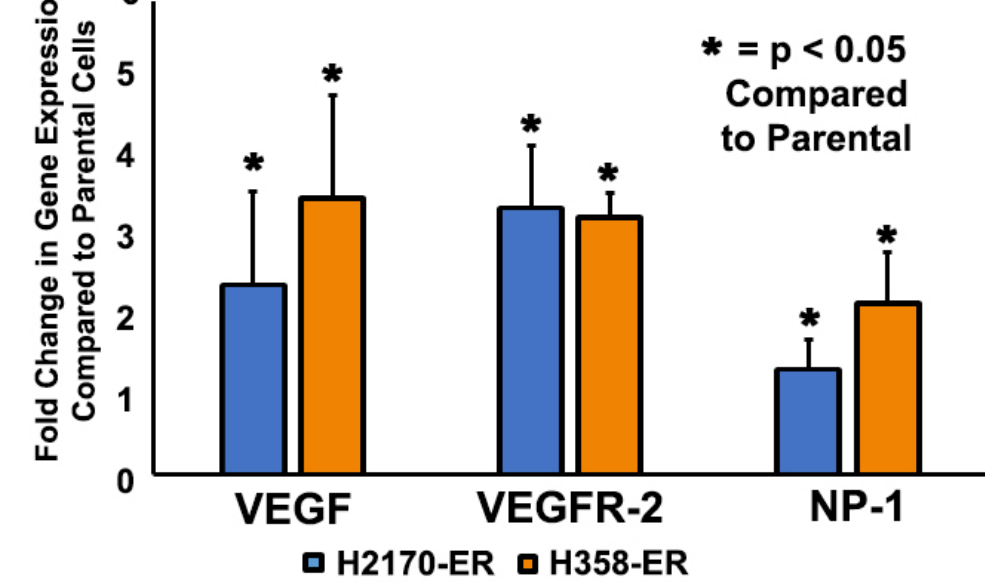
Figure 1. Increased gene expressions of VEGF, VEGFR-2, and NP-1 in Erlotinib-resistant NSCLC cell lines. For the analysis, 2.5 × 10 5 H358-P/ER and H2170-P/ER cells were plated in Petri dishes and allowed to adhere and grow for 24 h. The cells were then starved (RPMI + 0.5% BSA) for 24 h and total RNA was collected. Real-time quantitative polymerase chain reaction (qPCR) was then performed with three duplicates for each target gene as well as with a housekeeping gene (GAPDH). mRNA was quantified and analyzed for VEGF, VEGFR-2, and NP-1. The data was normalized with GAPDH and the graphical representation is relative to expression of the respective genes in H2170-P and H358-P cells. Statistical analyses demonstrated that the results were statistically significant ( p < 0.05) by way of two-tailed t -test analyses.